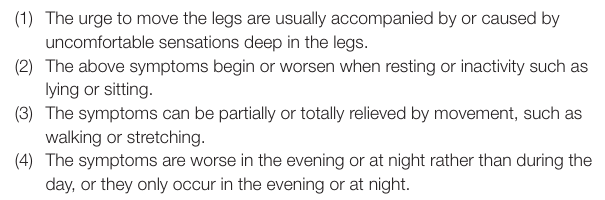
TABLE 1 | 2003 NIH/IRLSSG diagnostic